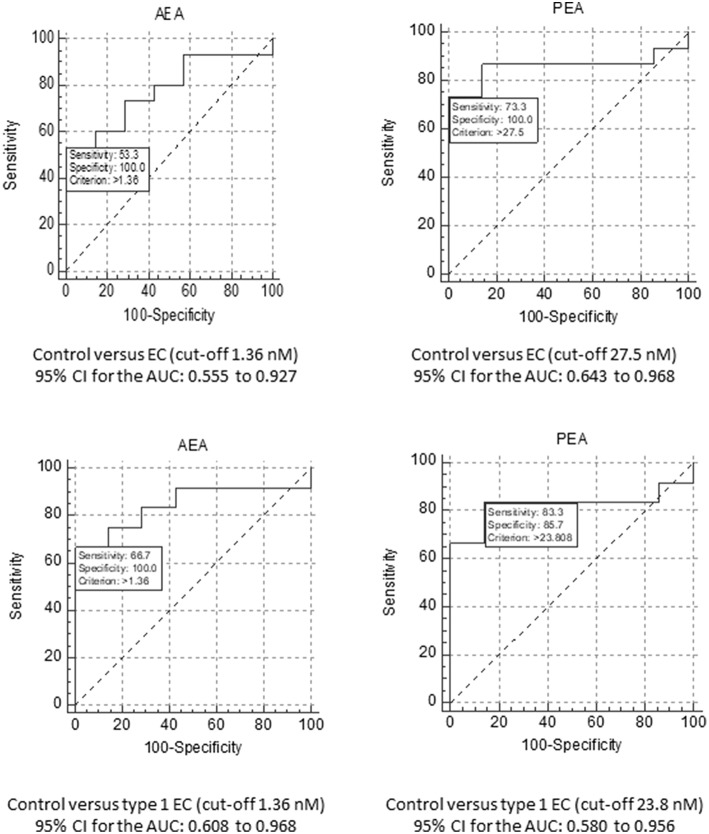
ROC analyses for AEA and PEA. The upper panels show the ROC analyses for AEA (Left) and PEA (Right) for the diagnosis of EC, using a cut-off plasma concentration of 1.36 nM for AEA and 27.5 nM for PEA. The data also show the sensitivity and specificity values for these biomarkers together with the value for the area under the ROC curve and their 95% confidence intervals (CI). The lower panels show similar analyses, but for the comparison of EC grade 1 tumour patients only compared to the controls. In this case, the cut-off plasma concentration remained at 1.36 nM for AEA and changed to 23.8 nM for PEA.